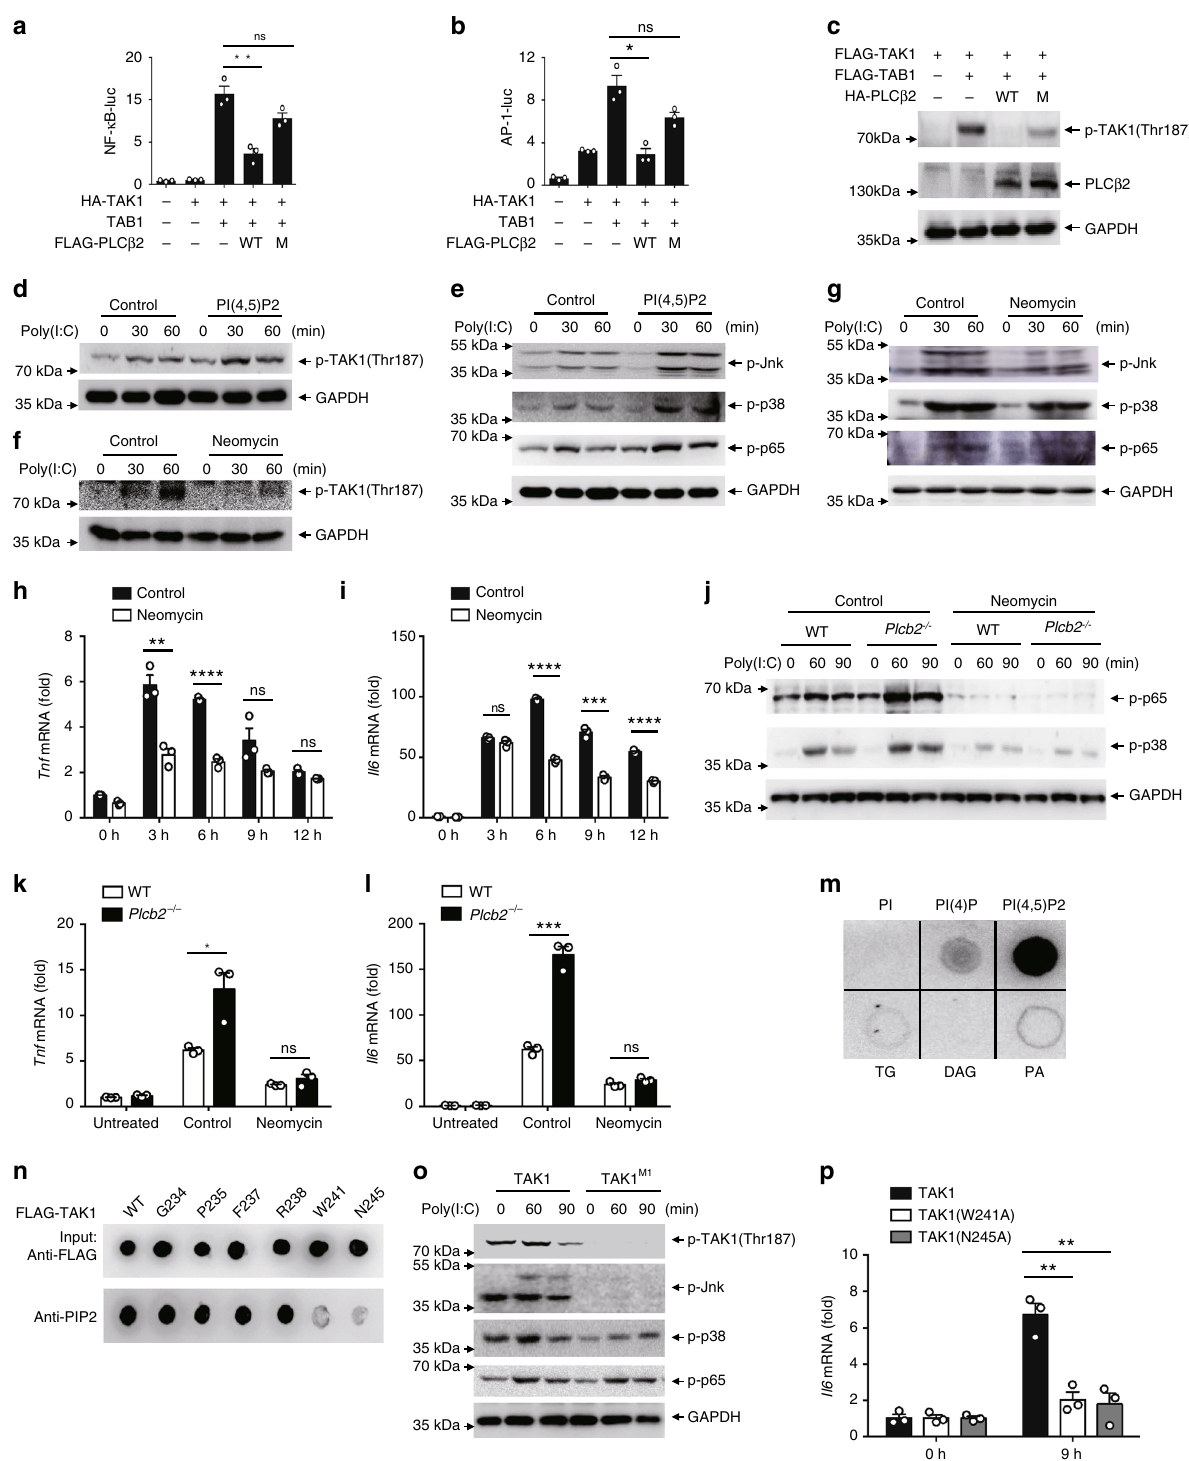
M-3M3FBS alleviates the pathogenesis of CVA16 infection . The agonist 2,4,6-trimethyl-N-(meta-3-tri fl uoromethyl-phenyl)- benzene sulfonamide (m-3M3FBS) has been reported to directly stimulate PLC activity 35 . Since we have identi fi ed PLC β 2 as a negative regulator of proin fl ammatory cytokines during viral infection, we next evaluated the effect of m-3M3FBS on virus- induced immune responses. Treatment with m-3M3FBS mark- edly suppressed TAK1 phosphorylation (Fig. 7a), as well as